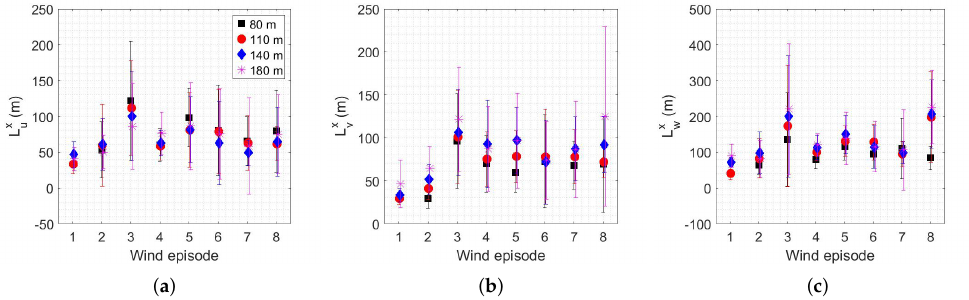
Figure 13. Mean values of along-wind turbulence length scales, obtained from Doppler wind lidar measurements at four different heights above the ground, for all eight wind episodes ( a – c